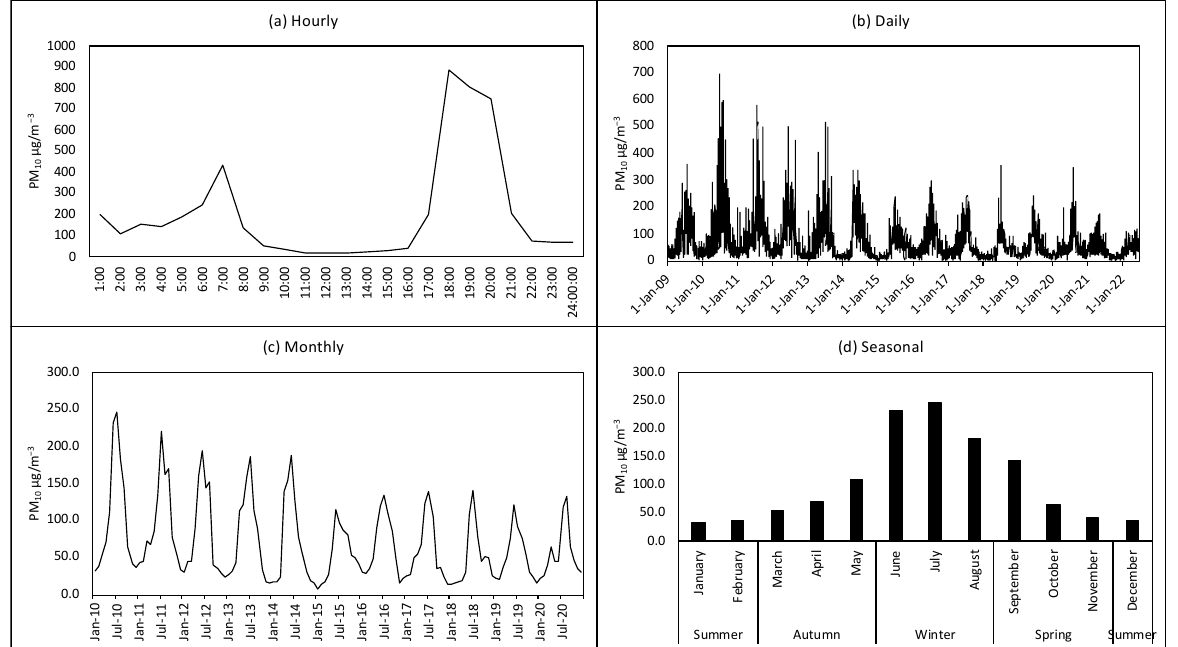
Figure 5. Daily, hourly, monthly and seasonal concentration of PM 10 observed at Secunda city.